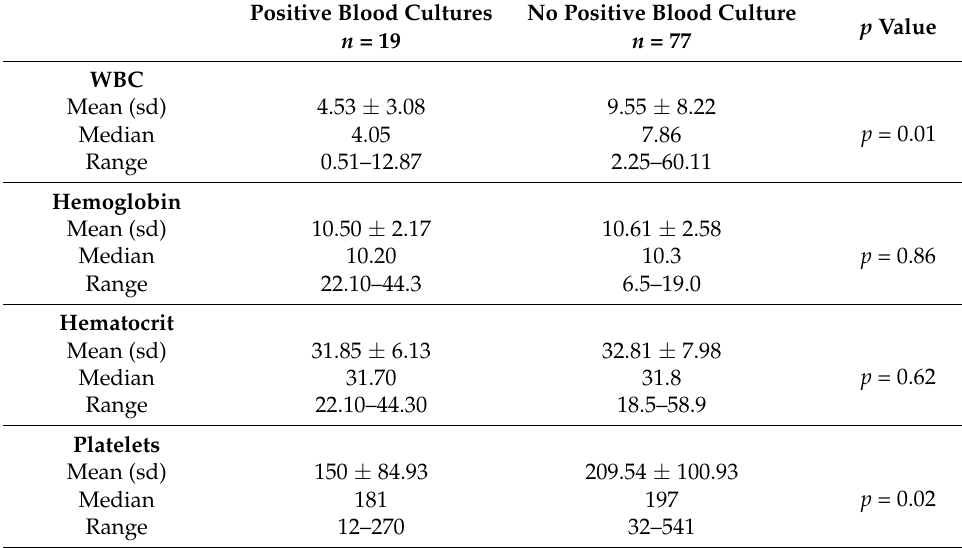
Table 3. Biomarkers statistics for tunneled CVCs.